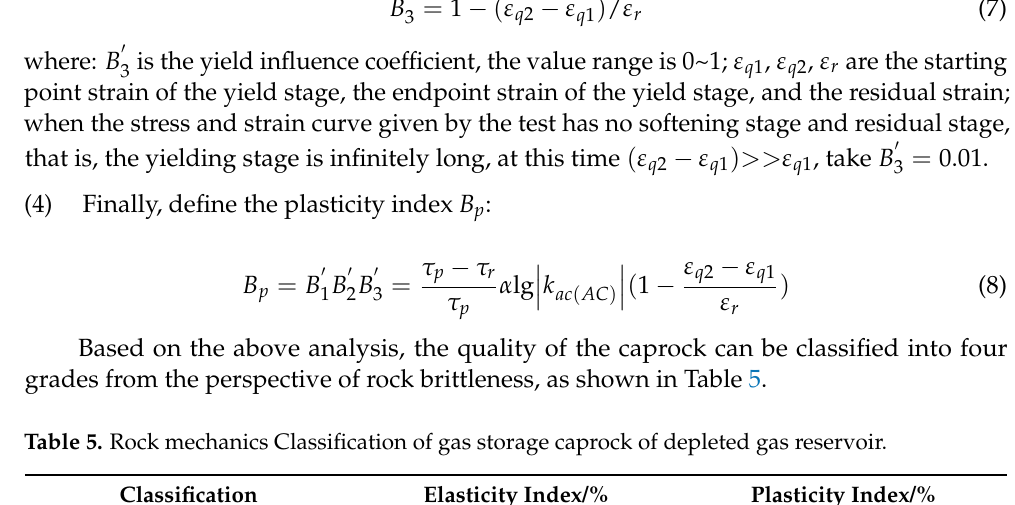
Table 5. Rock mechanics Classification of gas storage caprock of depleted gas reservoir.